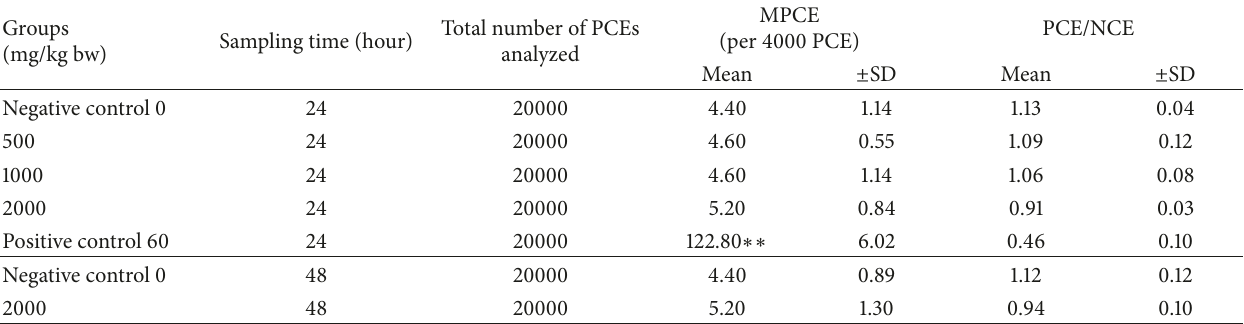
Table 4: Summary table of the results for the mouse micronucleus